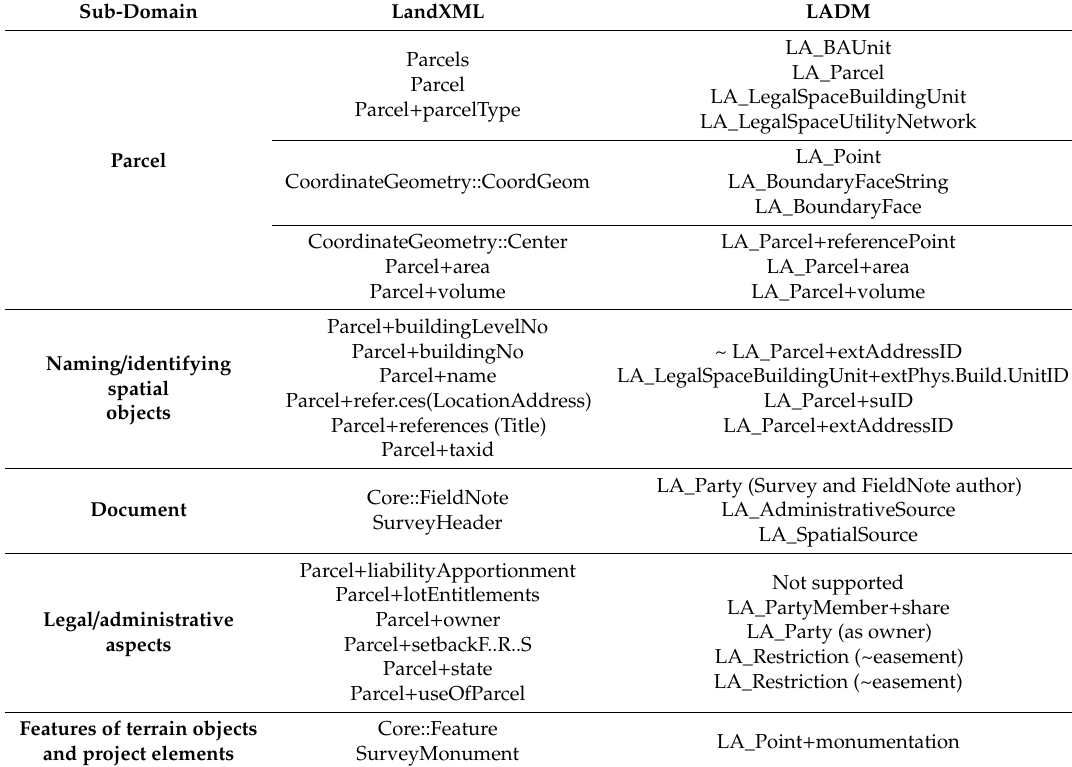
Table 1. Comparison of LandXML and LADM standards, adapted from